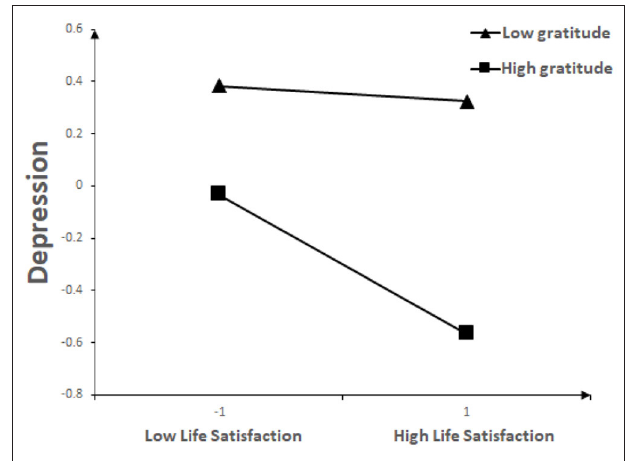
FIGURE 2 | Interaction between life satisfaction and gratitude on depression.